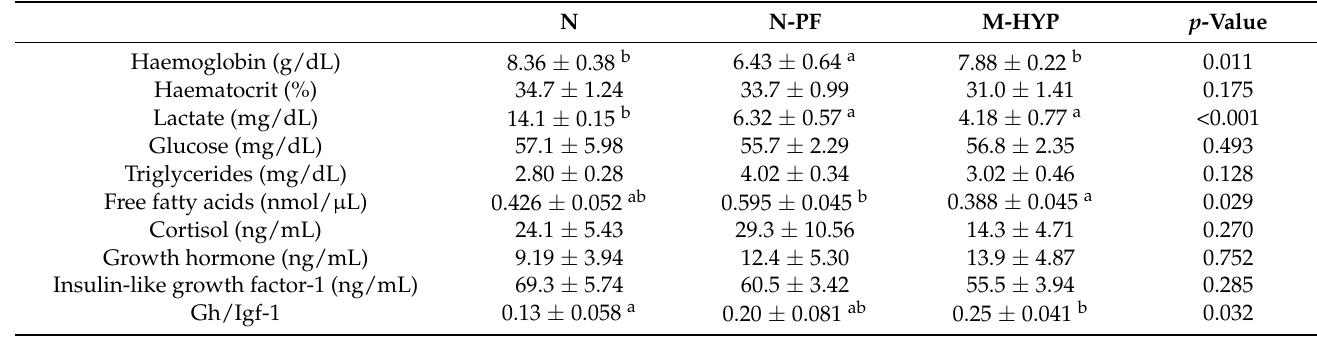
Table 2. Effects of mild-hypoxia conditioning on blood haematology and blood biochemistry of gilthead sea bream juveniles. Values are the mean ± SEM of 6–10 fish (2–3 fish per replicate tank). The p -values are the result of one-way ANOVA. Different superscript letters indicate significant differences between the experimental groups (SNK test, p <